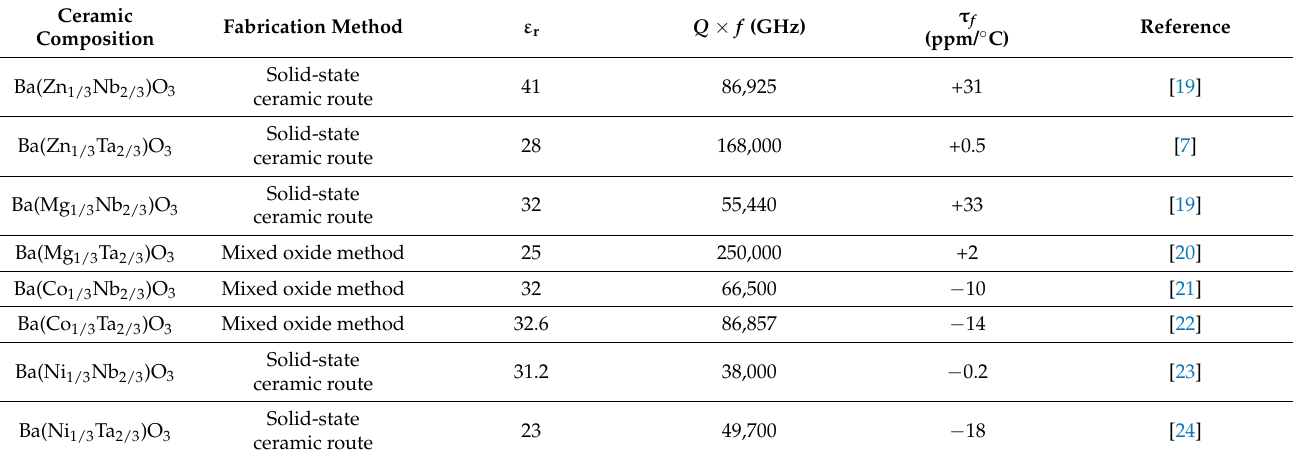
Table 1. The microwave dielectric properties of A(X l/3 Y 2/3 )O 3 ceramic